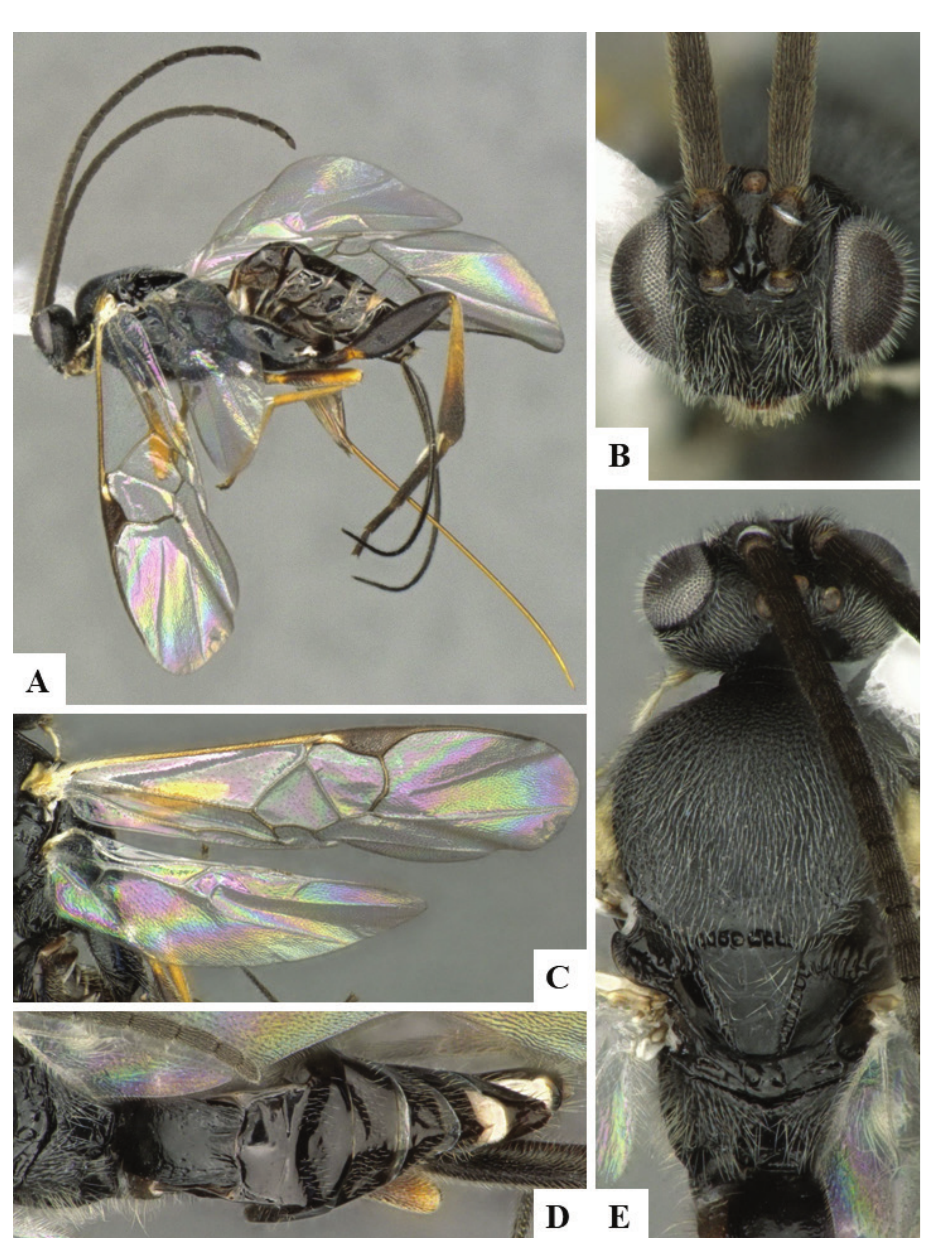
Figure 2. A–E Dolichogenidea angelagonzalezae sp. n., holotype. A habitus, lateral B head, frontal C wings D metasoma, dorsal E head and mesosoma,